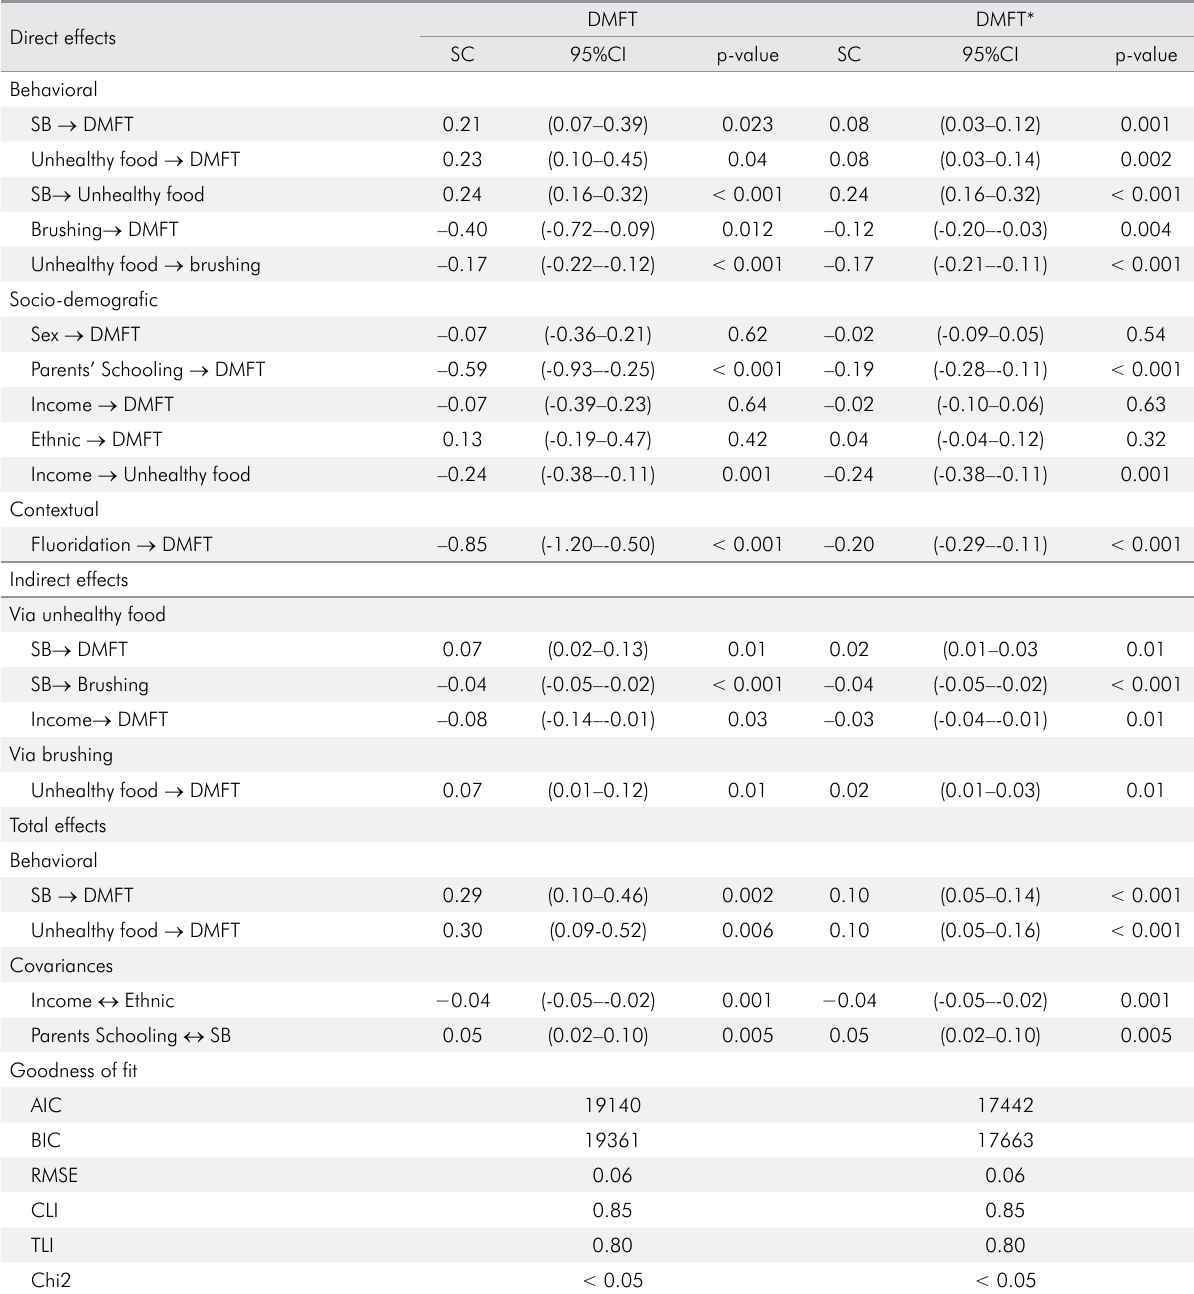
Table 2. Structural equation models for sedentary behavioral, unhealthy food comsumption, and oral health, SBMS 18 (n =